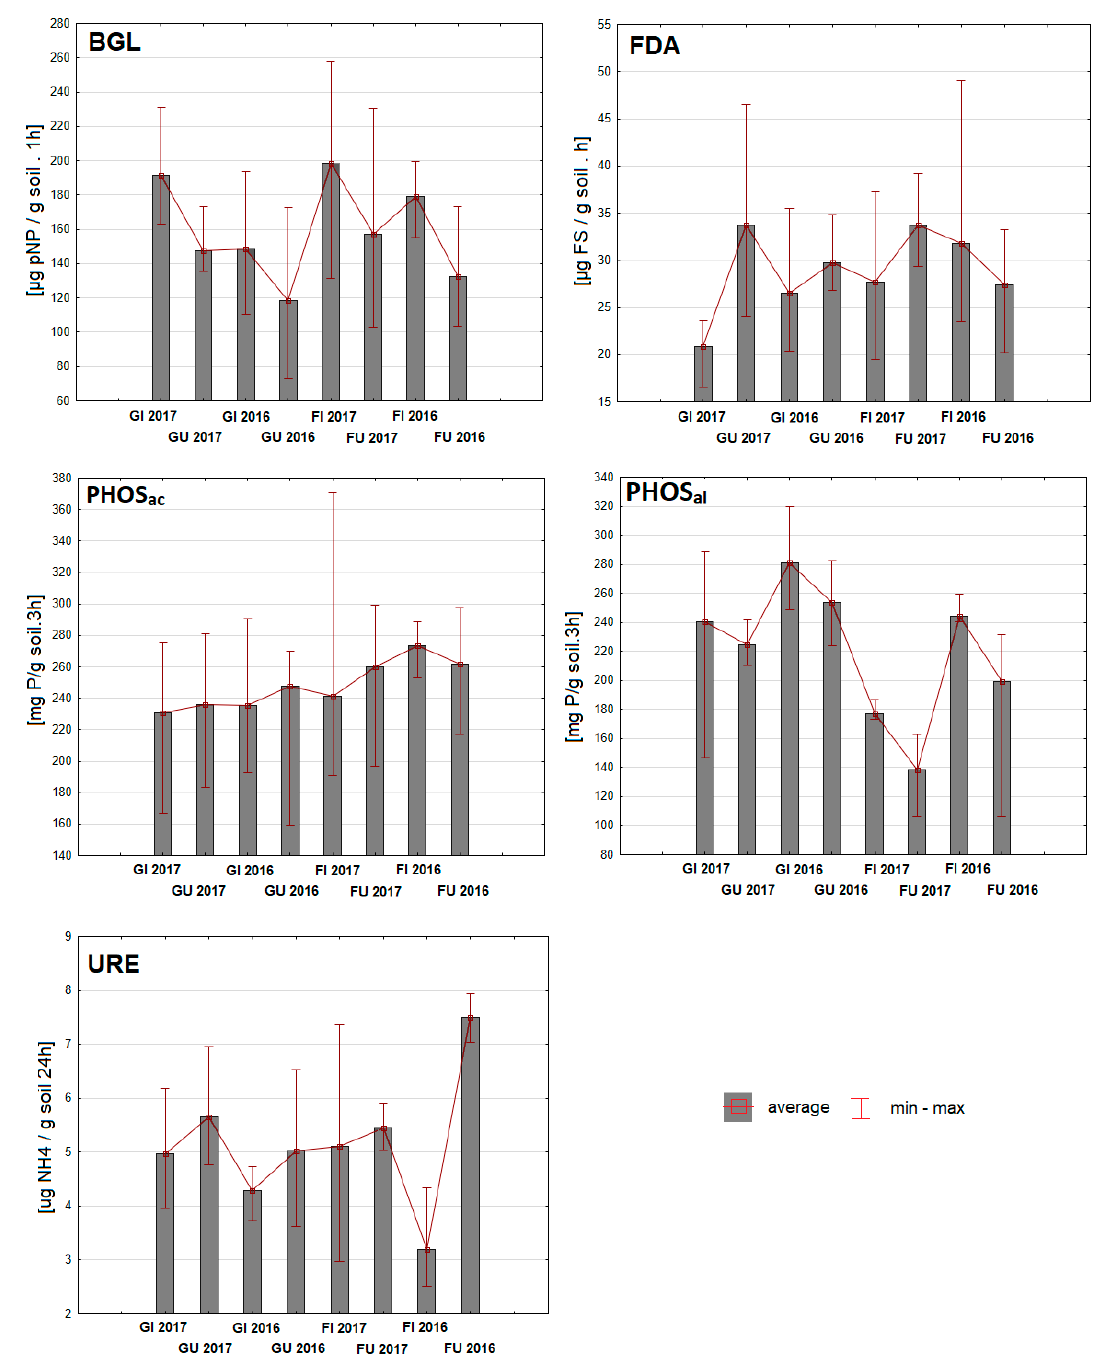
Figure 3. Soil microbial indicators in two ecosystems (forest and grassland) under invaded and uninvaded sites in 2016 and 2017 (FDA (fluorescein diacetate activity), BGL (beta-glucosidase activity), URE (urease activity), PHOS al (alkaline phosphatase activity), PHOS ac (acidic phosphatase activity), FI (forest invaded ecosystem), FU (forest uninvaded ecosystem), GI (grassland invaded ecosystem), GU (grassland uninvaded ecosystem)).